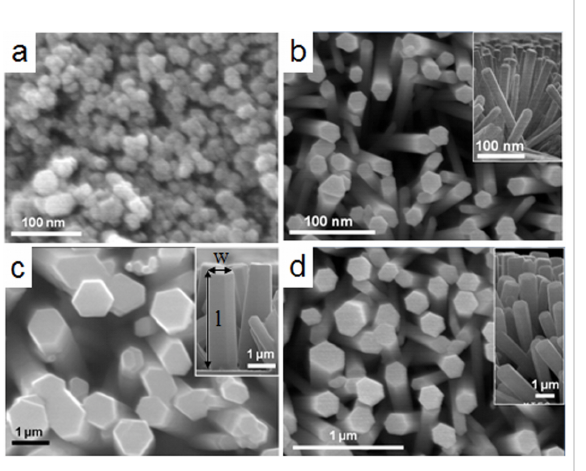
Figure 2: Scanning electron micrograph of (a) ZnO nanoparticle thin film on glass substrate, (b) Sample 1 (0.1 mM), inset: cross-sectional view, (c) Sample 2 (1.0 mM), inset: cross-sectional view, and (d) Sample 3 (10.0 mM), inset: cross-sectional view.